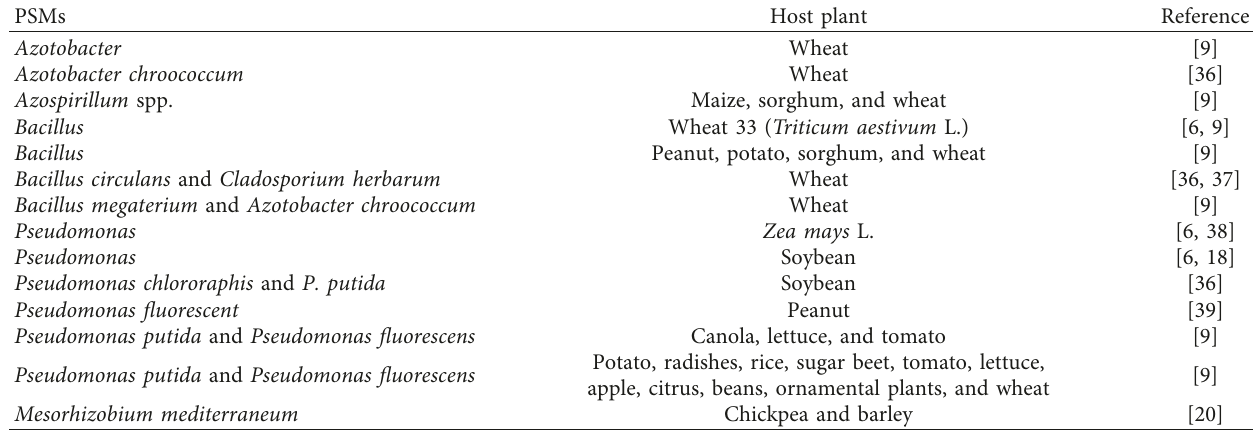
Table 3: Effect of PSM on growth and yield performance of different